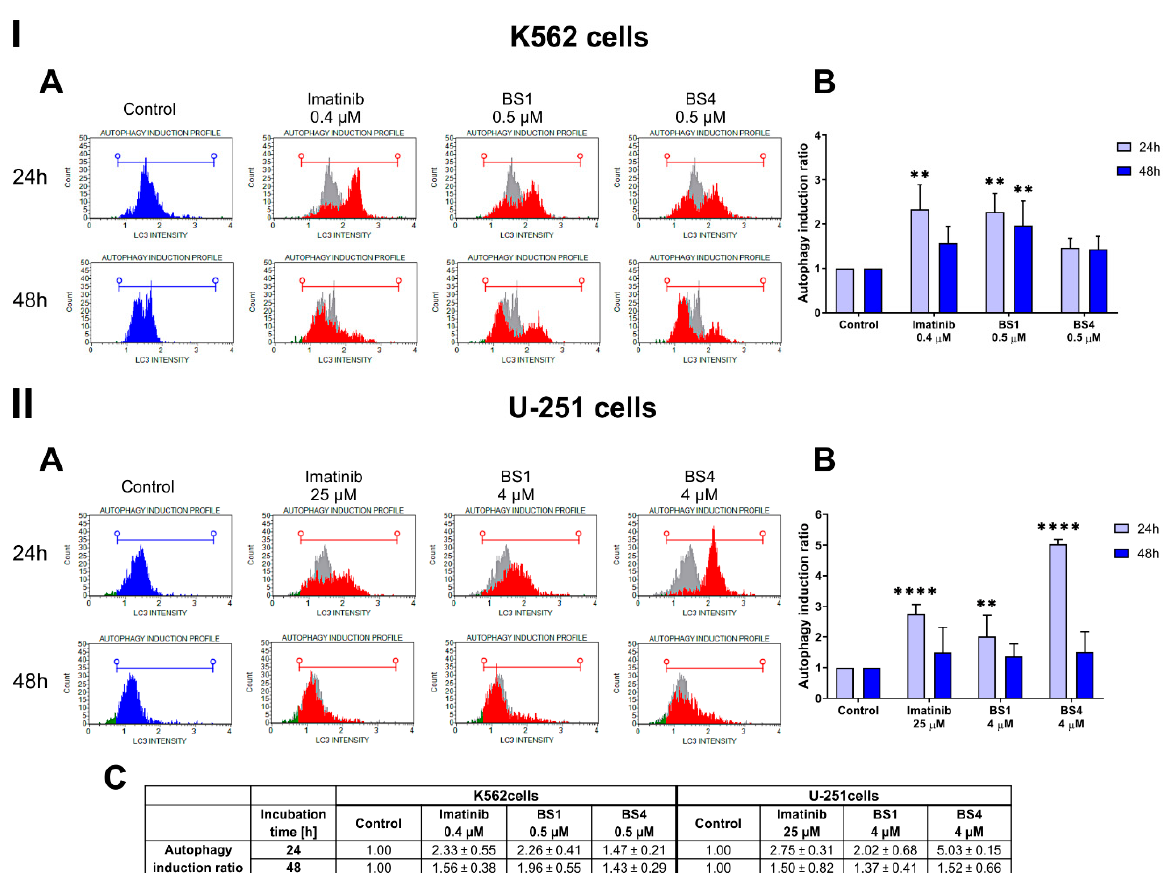
Figure 6. Assessment of the effect on inducing autophagy in the K562 ( I ) and U-251 ( II ) cells after a 24 and 48 h incubation with the tested compounds ( BS1 , BS4 ) at various concentrations. The representative histograms from one of several independent experiments include the autophagy induction profile ( A ). The autophagy induction ratio chart with the statistical analysis using a one-way ANOVA with Bonferroni’s post-hoc test: ** p < 0.01, **** p < 0.0001 compared to the untreated cells (control) ( B ). The table contains the mean ± SD percentage of the autophagy induction ratio from all of conducted experiments ( C ).